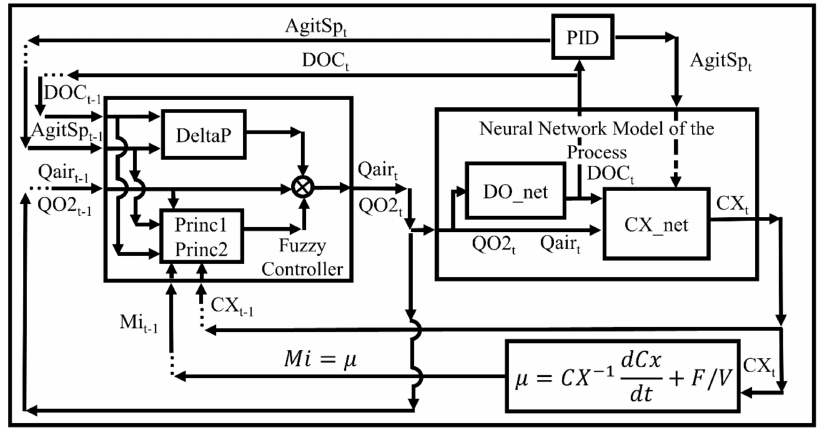
Figure 4. Simulator scheme comprised of the fuzzy controller, neural network model of the process, PID controller, and specific growth rate equation.